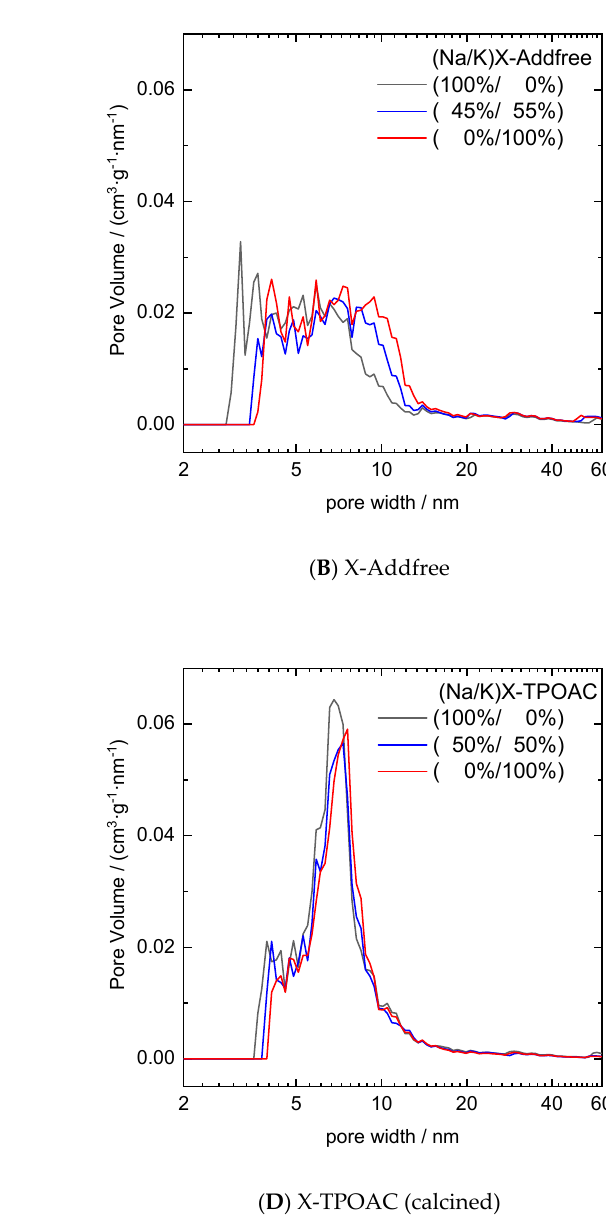
Figure 4. Pore size distributions of zeolite X from the different synthesis routes with varying amounts of potassium ions before (NaX, no K content) and after (NaKX with a mixture of Na and K; KX with almost 100 % K) ion exchange.